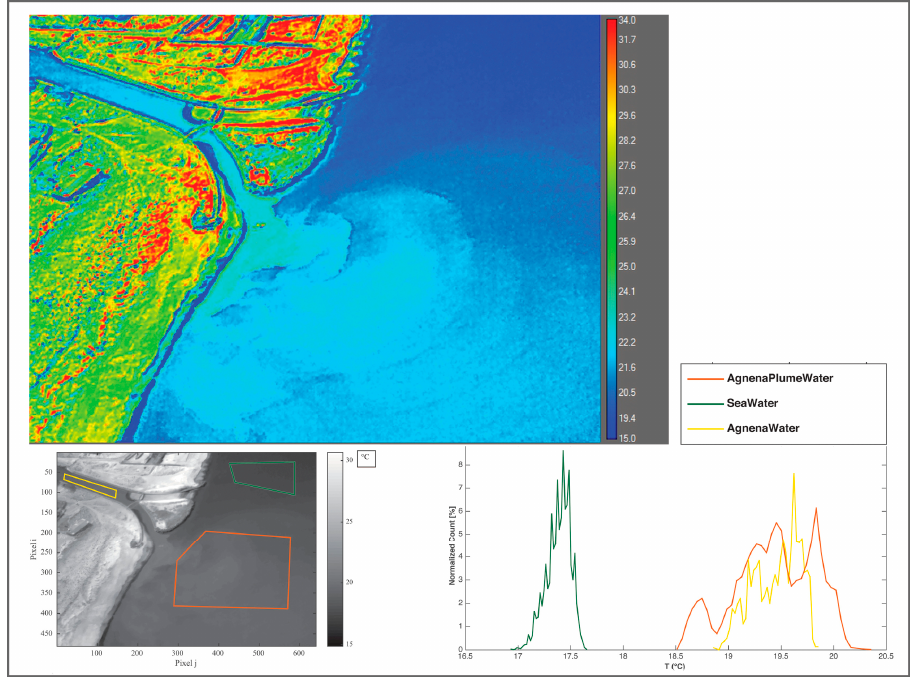
Figure 5. Thermal image of Agnena plume with histogram of radiometric temperature for areas of the channel, seawater and area of the plume.